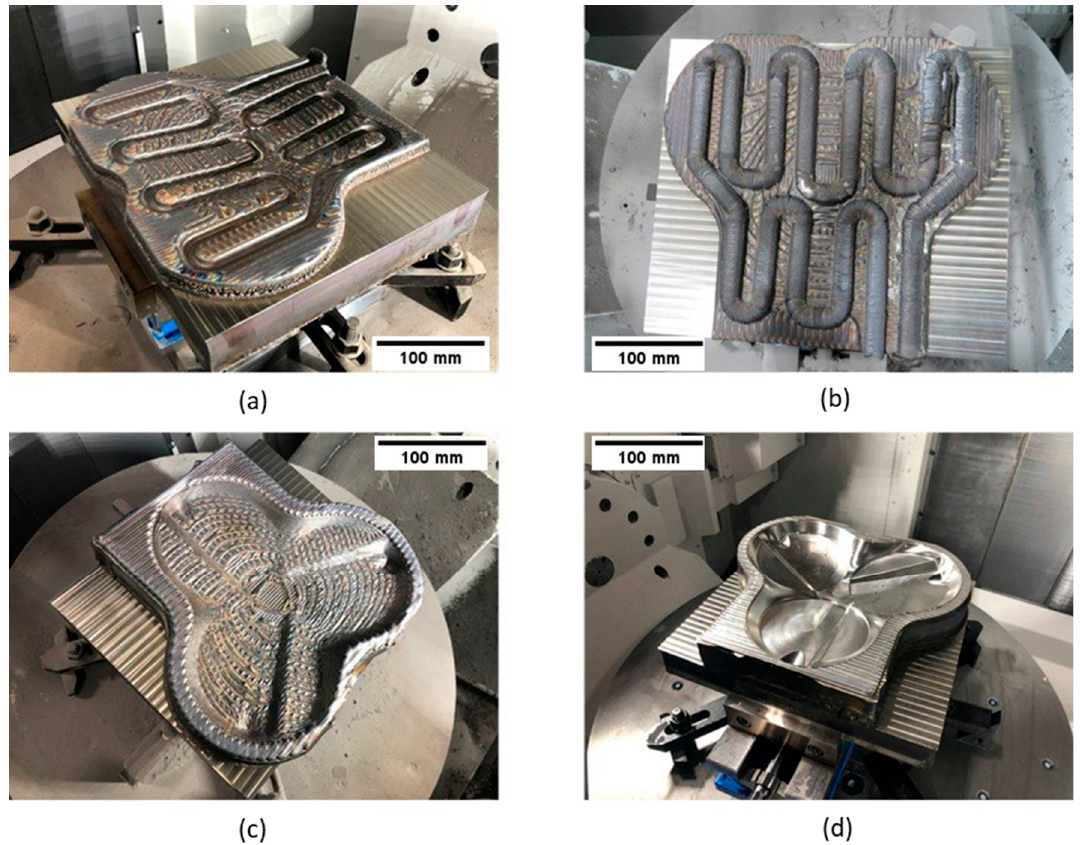
Figure 5. Various stages of mold manufacturing: ( a ) bottom half deposited up to midpoint of cooling channels (refer to video), ( b ) deposited cooling channels, ( c ) finished deposition of mold bottom, and ( d ) finished mold.